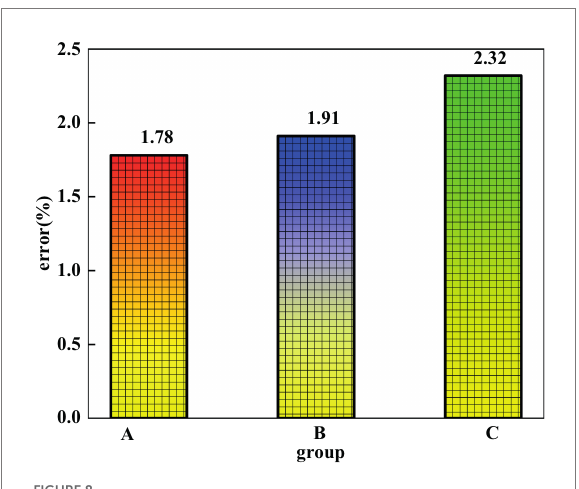
FIGURE 8 Prediction errors of three characteristics related to mental health and literature dissemination